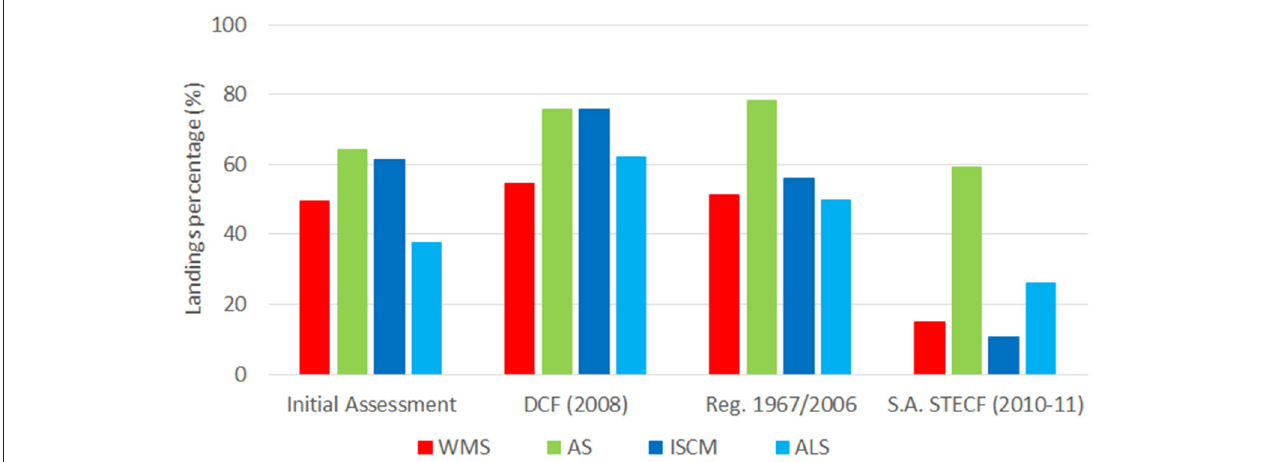
FIGURE 5 | Percentage of landings corresponding to the stocks considered by EU member states within their Initial Assessment and in relation to data collection and policy obligations. Estimates are given at MSFD subregional level. WMS, Western Mediterranean Sea; AS, Adriatic Sea; ISCM, Ionian Sea and Central Mediterranean; ALS, Aegean-Levantine Sea. DCF (2008): Percentage of landings corresponding to stocks’ list object of the DCF ( EU, 2008). Reg. 1967/2006: Percentage of landings corresponding to species subjected to Minimum Landings Size according to the Mediterranean Regulation (Appendix 3, EU, 2006). S.A. STECF: Percentage of landings corresponding to stocks which were assessed on 2010–2011 by STECF (Cardinale and Osio, 2012).